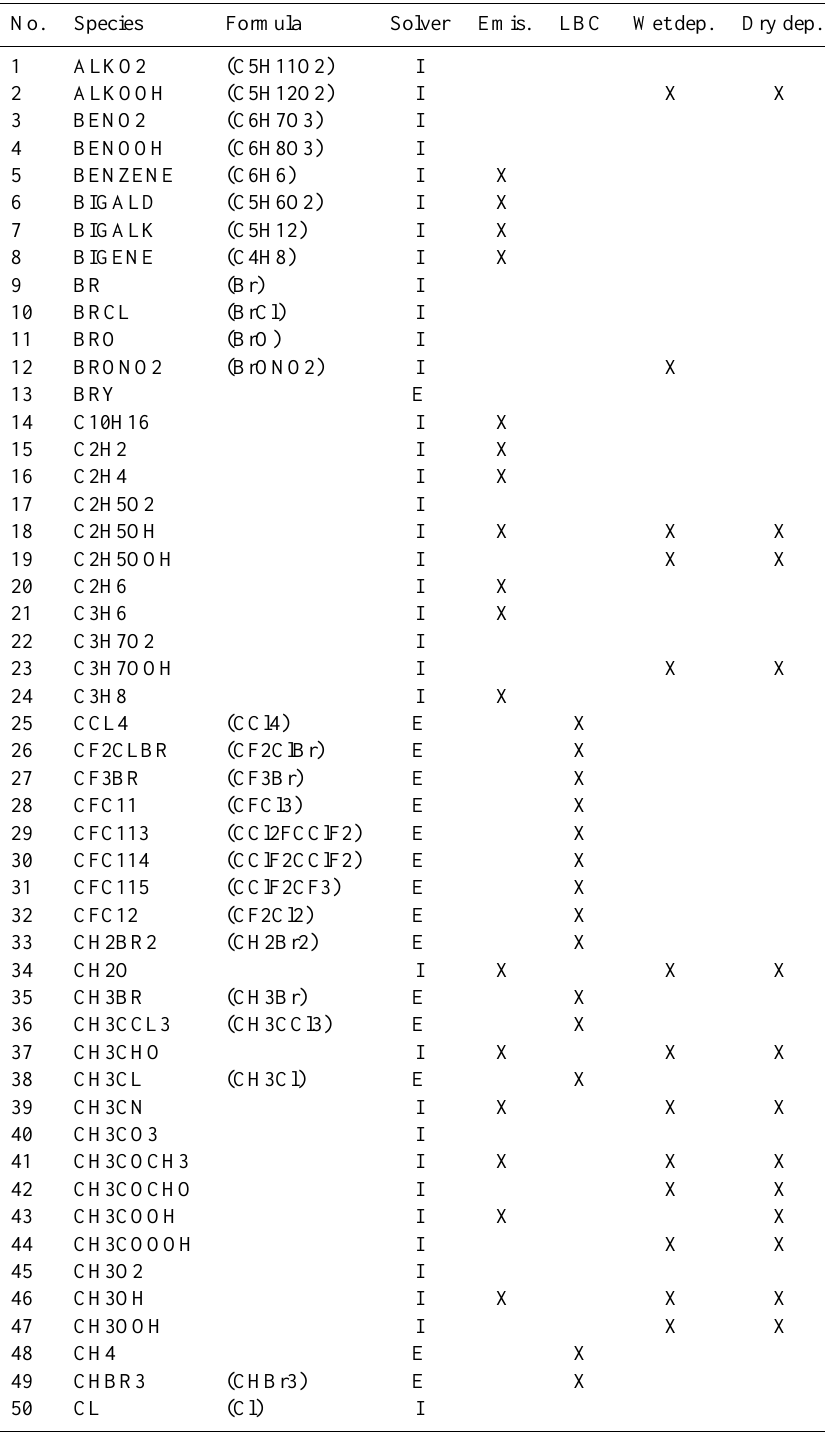
Table A1. Chemical species in CAM4-chem, chemical formula, solver (either explicit (E) or semi-implicit (I)), lower boundary conditions (LBC), and wet and dry deposition of